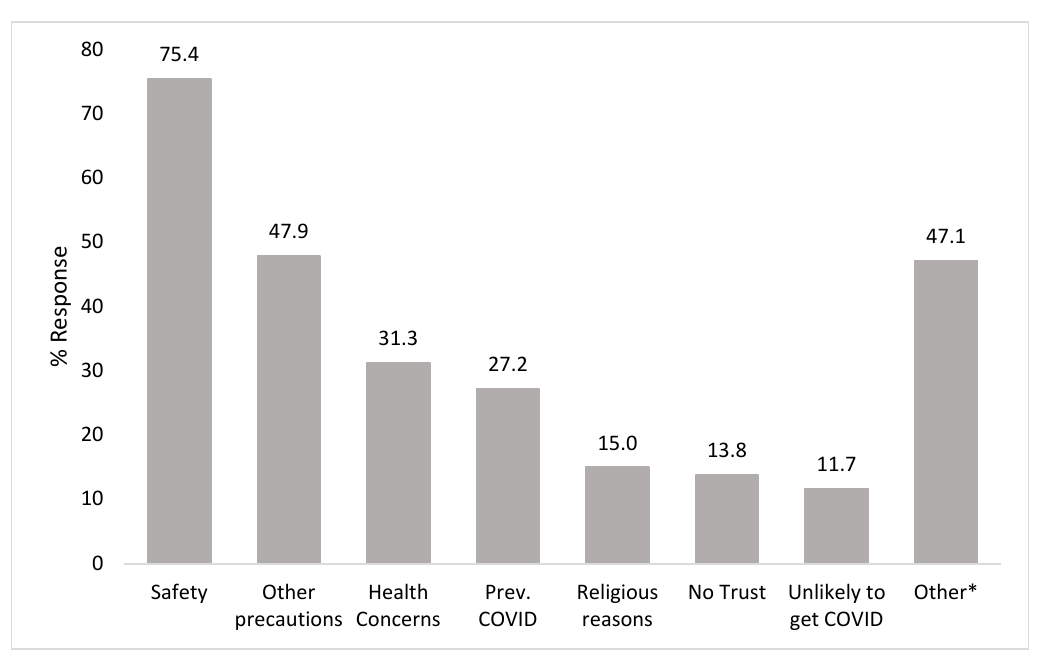
Figure 1. Reasons for primary-series vaccine hesitancy. * “Other” category includes write-in responses (41.4%), “I want to wait and see until more people get the vaccine” (29.1%), “My friends and/or family are not getting it” (0.7%), and “I’m concerned about what other people might think” (0.4%).